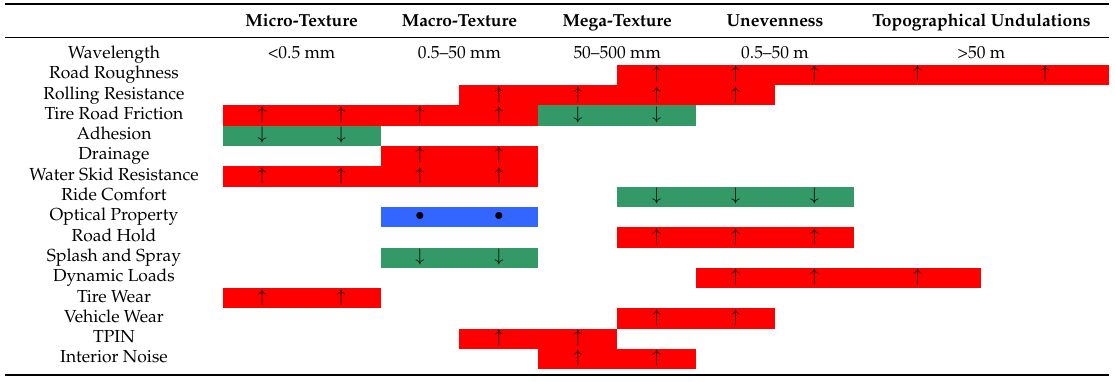
Table 12. Texture parameters and influence on tire/pavement characteristics (red ↑ indicates increase, green ↓ indicates decrease and blue • indicates complex) (modified from Dimitri, 2012 [91]; Wayson, 1998